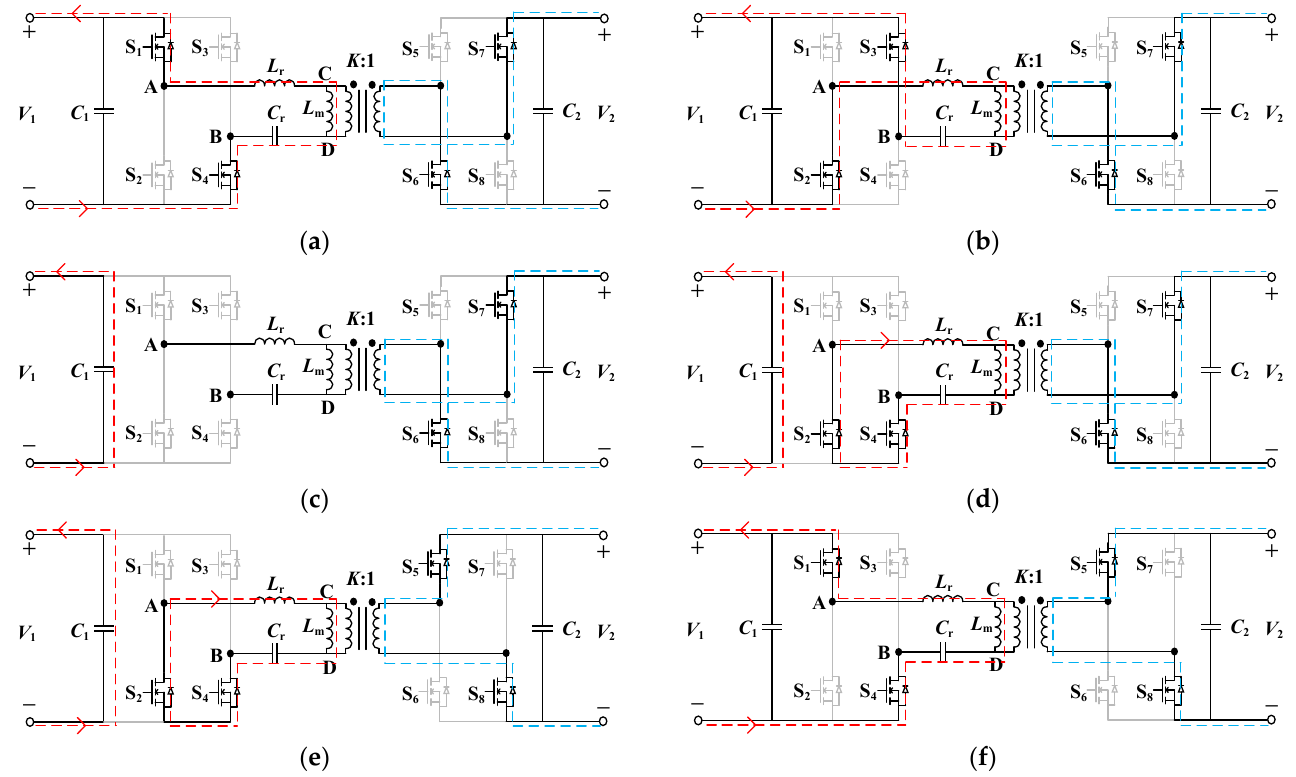
Figure 3. Equivalent circuit under different modes. ( a ) t 0 – t 1 , ( b ) t 1 – t 2 (CCM) , ( c ) t 1 – t 2 (DCM), ( d ) t 2 – t 3 , ( e ) t 3 – t 4 , ( f ) t 4 – t 5.